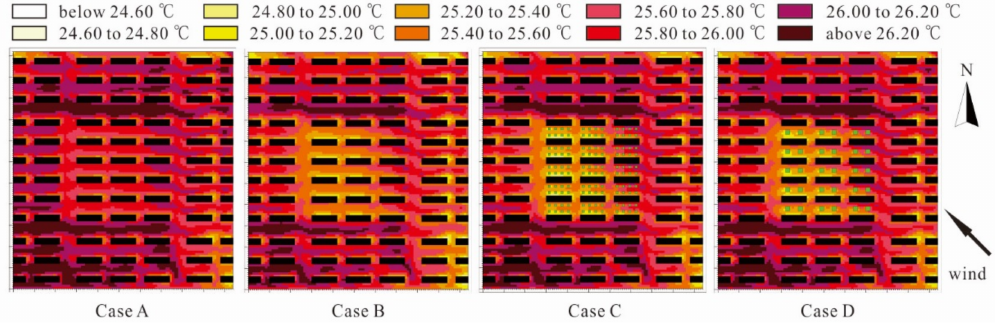
Figure 6. Spatial distribution of temperature at pedestrian height on 23 June at